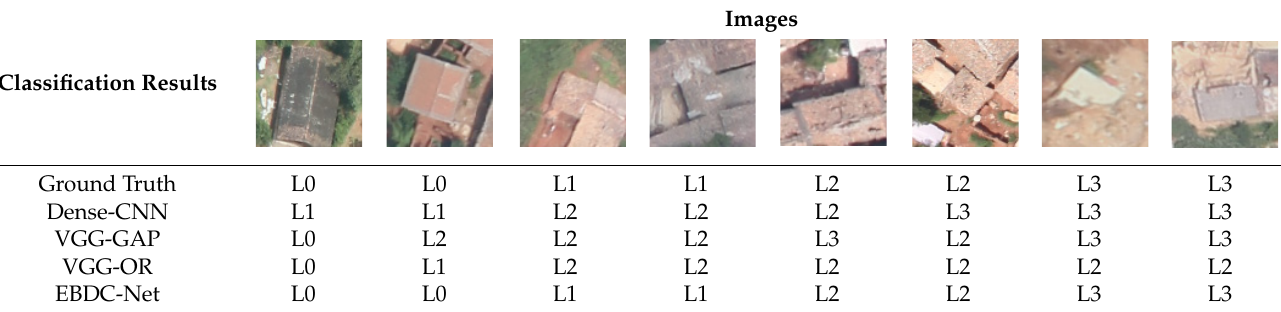
Table 12. Comparison of different methods in the refined assessment of building damage (L0: intact; L1: slightly damaged; L2: severely damaged; L3: collapsed).